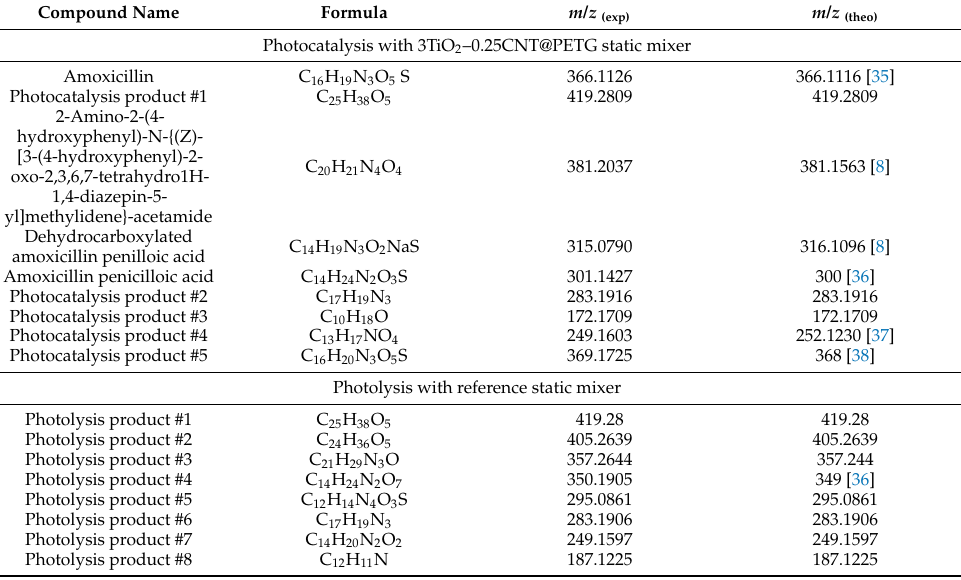
Table 4. List of compounds determined by MassHunter Workstation and theoretical m / z